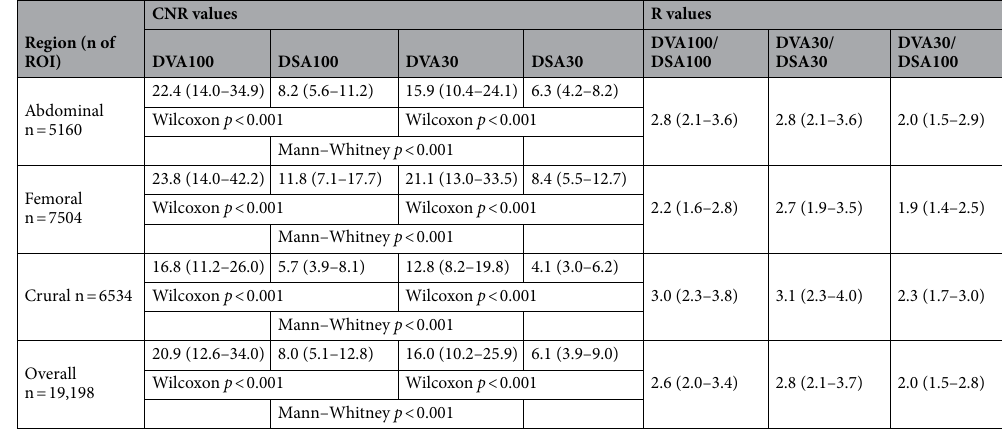
Table 2. CNR analysis. Values expressed as the median and the interquartile range (Q1–Q3). Wilcoxon signed rank test and Mann Whitney U test were used to compare paired and unpaired data sets, respectively. ROI: Region of Interest; DVA: Digital Variance Angiography, DSA: Digital Subtraction Angiography. The index defines the applied protocol, 100: normal dose, 30: